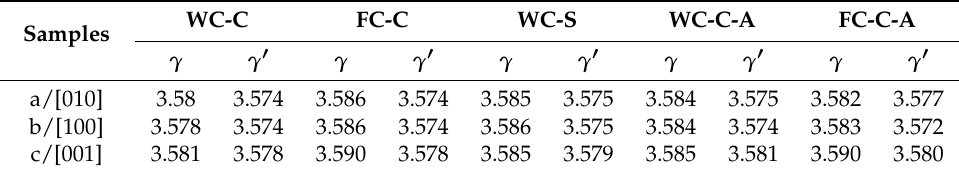
Table 2. Lattice parameters of different samples derived from fitting the {400} reflection and the {331} reflection. The deviations of the derived lattice parameters are in units of the last digit of the calculated values.